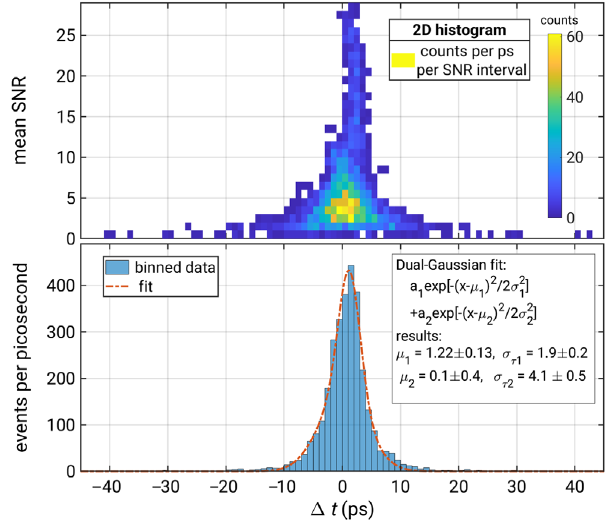
FIG. 15. Top: Two-dimensional histogram of relative shower energy vs measured delay for selected runs. The distribution at higher energies has a slightly different mean delay than the lower energy distribution. Bottom: a sum of two-Gaussian fit to the data, where the higher energies fit to a ∼ 1 - ps delay offset and a narrower timing distribution than the lower